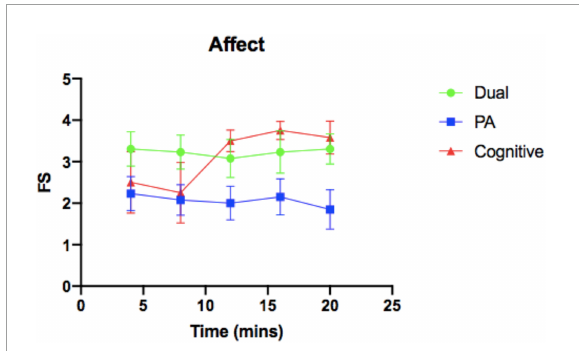
FIGURE3 Affect over 20-min intervention. FS, Feeling Scale; PA, physical activity.